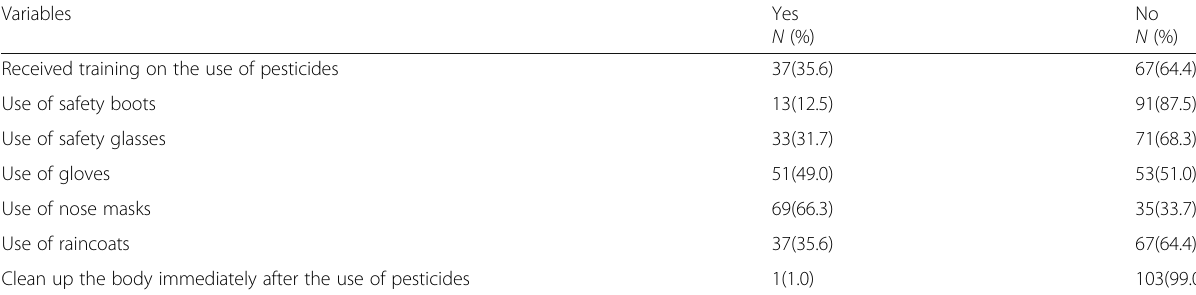
Table 3 Participants ’ practices relating to the training and use of PPE, Cameroon, 2017 ( N = 104) Variables